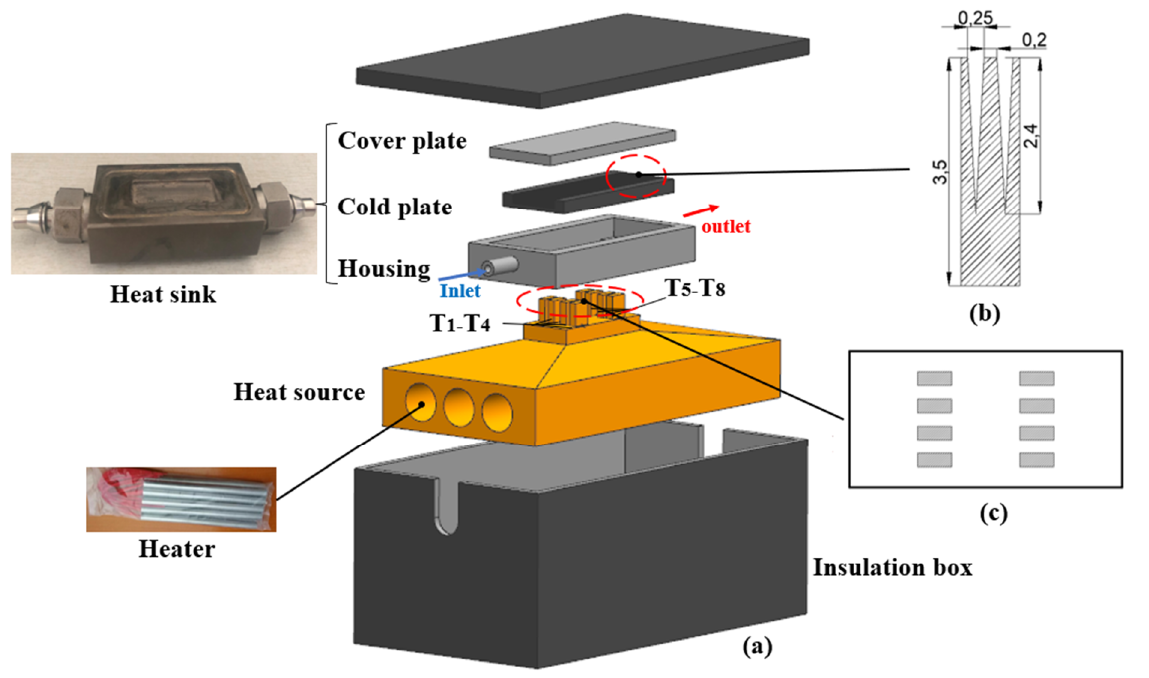
Figure 2. Schematic diagram of the test zone. ( a ) Test area structure. ( b ) Microchannel size. ( c ) Heat sources distribution.